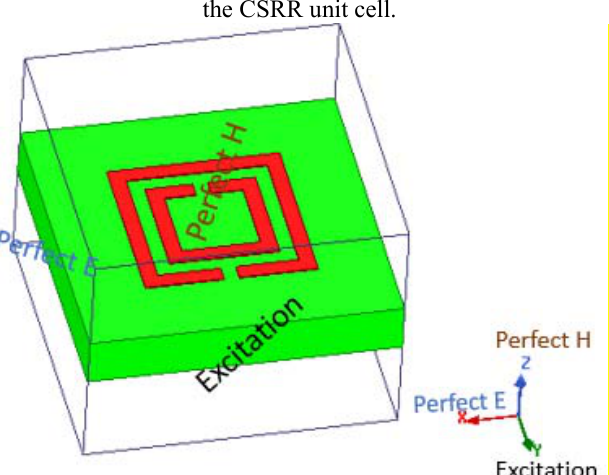
Figure 4: SRR unit cell setup for transmission analysis.